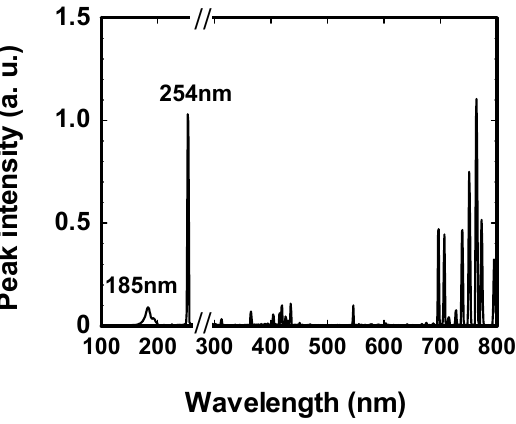
Figure 9. Vacuum-UV, UV, Visible and near-IR wavelengths emitted by the MDEL under microwave irradiation. Reproduced from [47]. Copyright 2009 by the Royal Society of